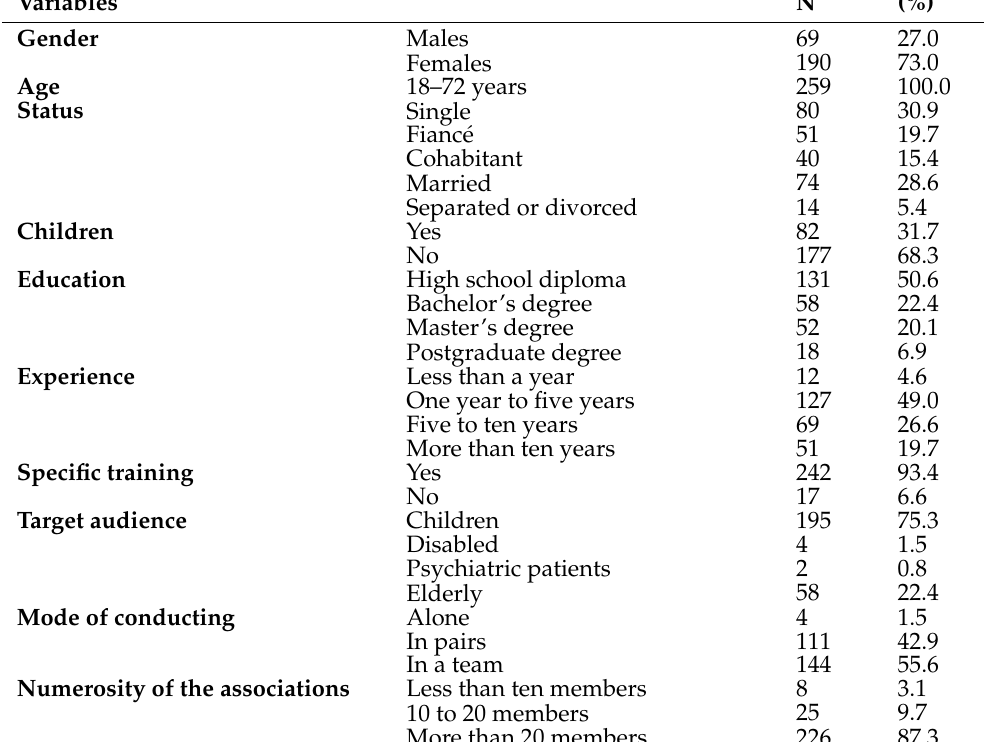
Table 1. Descriptive statistics for socio-demographic